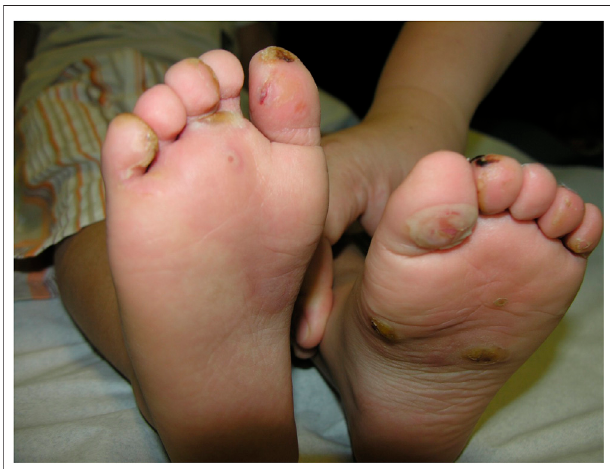
FIGURE 2 | Clinical presentation of epidermolysis bullosa simplex.